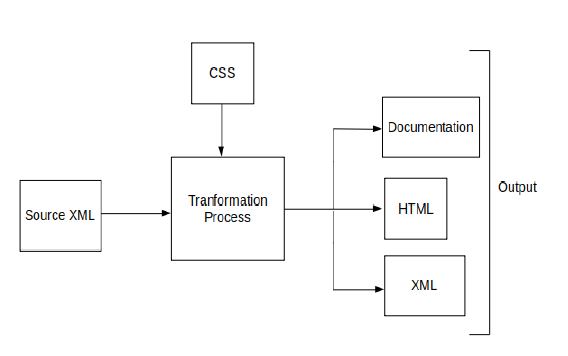
Figure 1. Architecture diagram of Apache Velocity